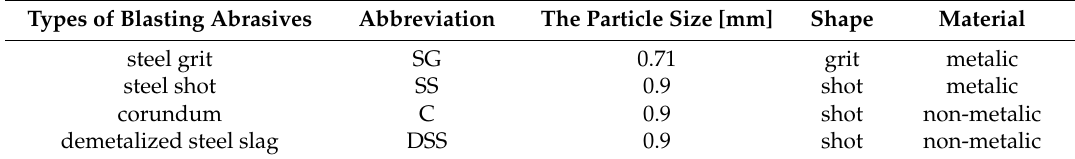
Table 5 is summary table regarding the applied abrasives. Table 5. Used types of blasting